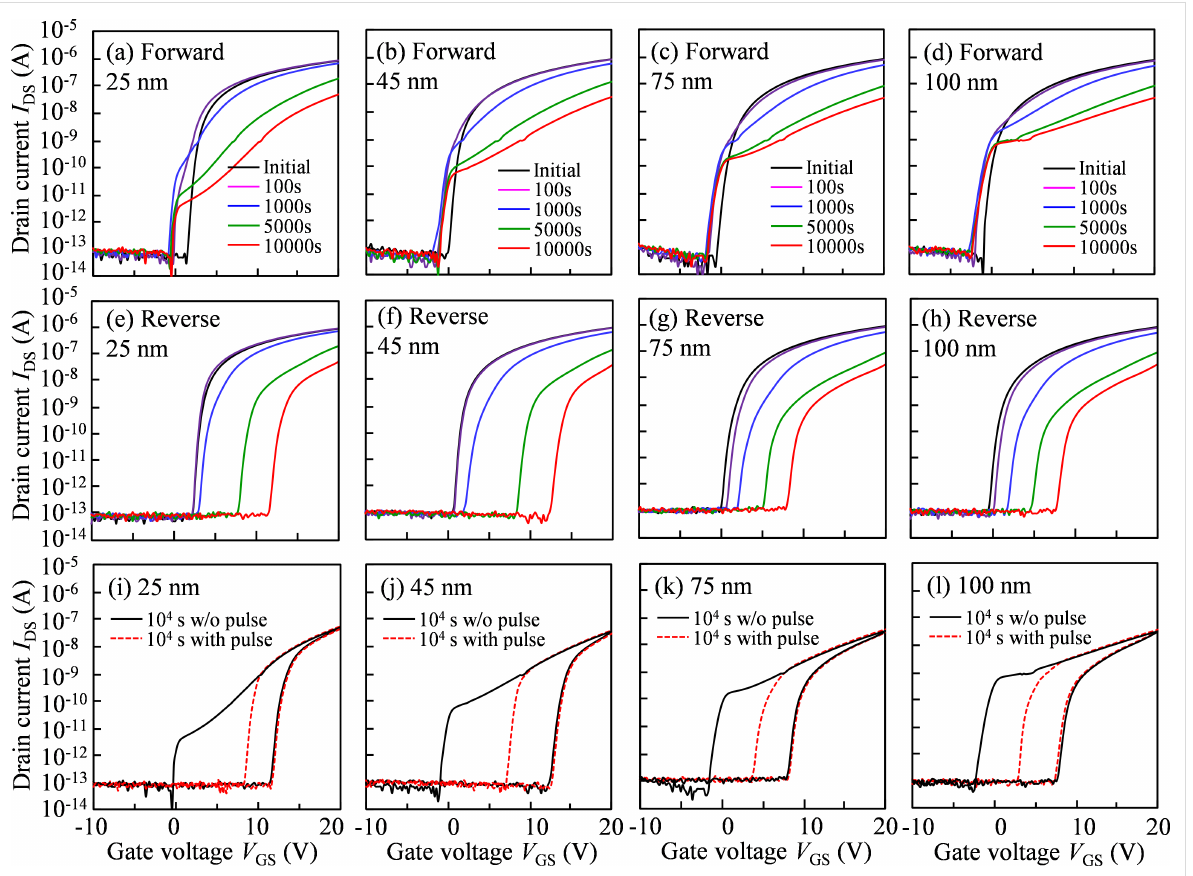
Figure 3: Variation in the transfer characteristics in the forward measurement for a-IGZO TFTs with (a) T IGZO = 25, (b) 45, (c) 75, and (d) 100 nm, and in the reverse measurement with (e) T IGZO = 25, (f) 45, (g) 75, and (h) 100 nm as a function of the stress duration for 10 4 s under − 30 V V GS NBIS. Transfer characteristics of a-IGZO TFTs with (i) T IGZO = 25, (j) 45, (k) 75, and (l) 100 nm after 10 4 s NBIS without and with a gate pulse of 1 ms width and 10 V